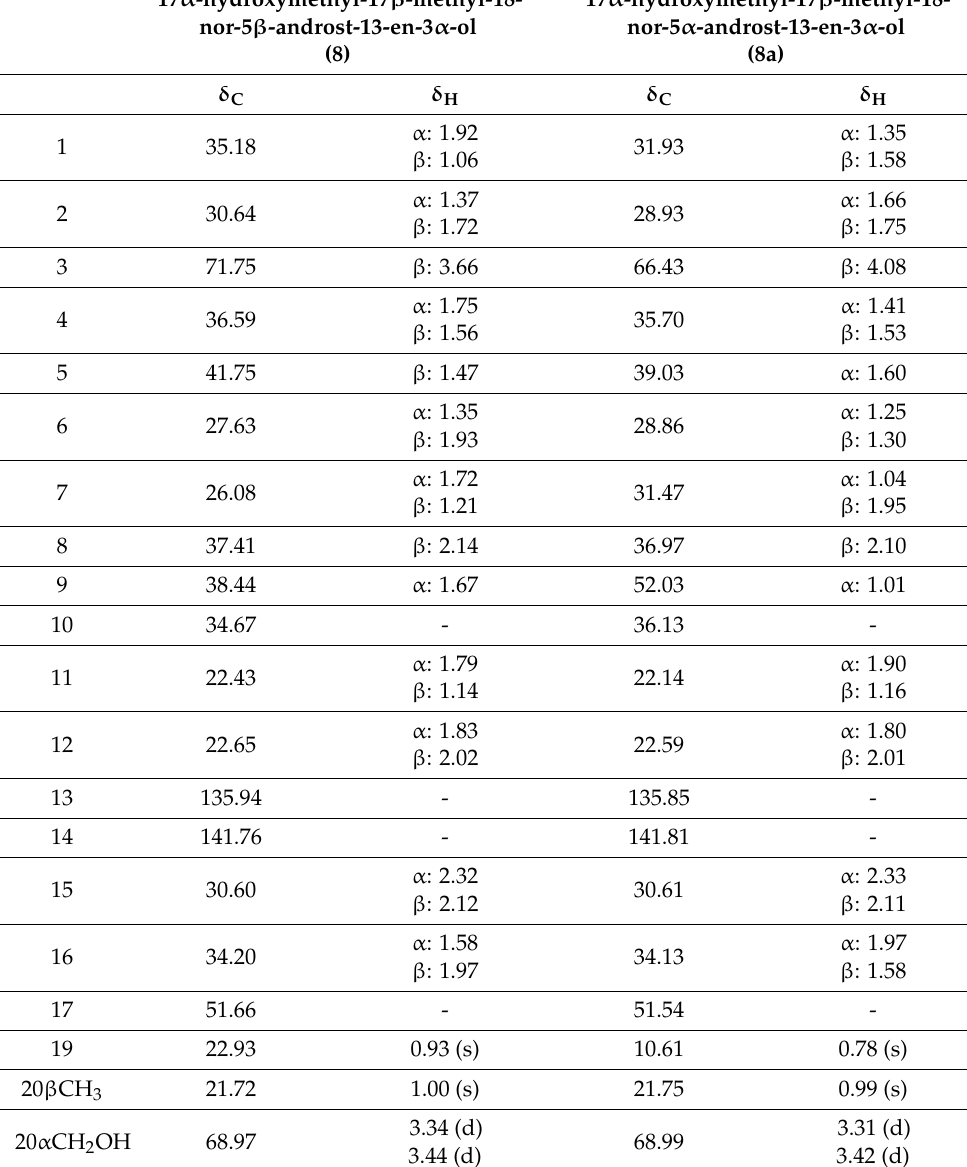
Table 2. 1 H and 13 C NMR spectral data of 17 α -hydroxymethyl-17 β -methyl-18-nor-5 β -androst-13-en- 3 α -ol ( 8 ) and 17 α -hydroxymethyl-17 β -methyl-18-nor-5 α -androst-13-en-3 α -ol ( 8a ). Multiplicity of signals indicated as singlet (s), doublet